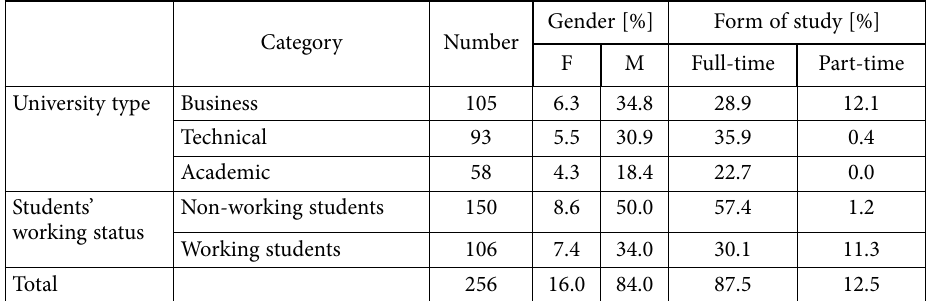
Table 1. Respondents’